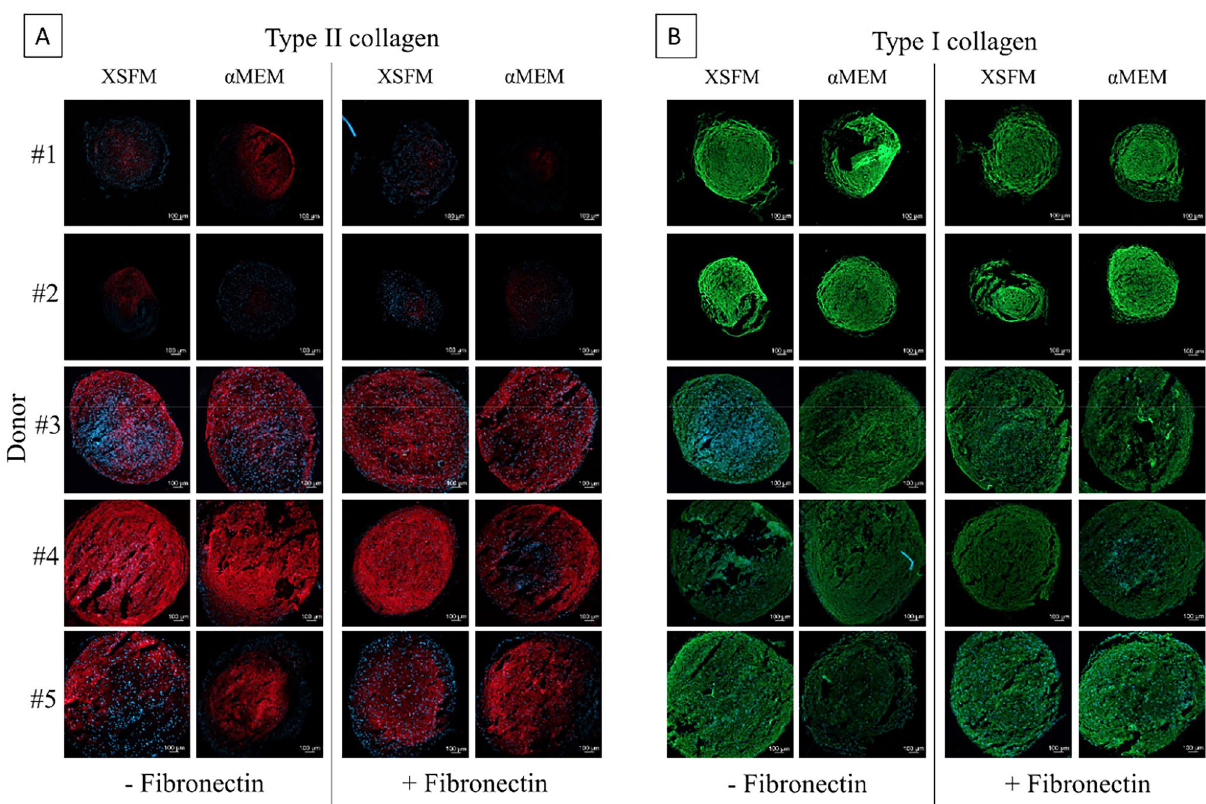
Figure 6. Immunohistological analysis of the chondrogenic potential of BMSCs expanded in different cell culture media (n = 5 donors). Pellet cryosections stained for type II ( A ) and type I collagen ( B ). The intensity of fluorescent secondary antibody is directly proportional to the production of different collagen content, while DAPI (blue) stains cell nuclei. Scale bar (bottom right in each picture) = 100